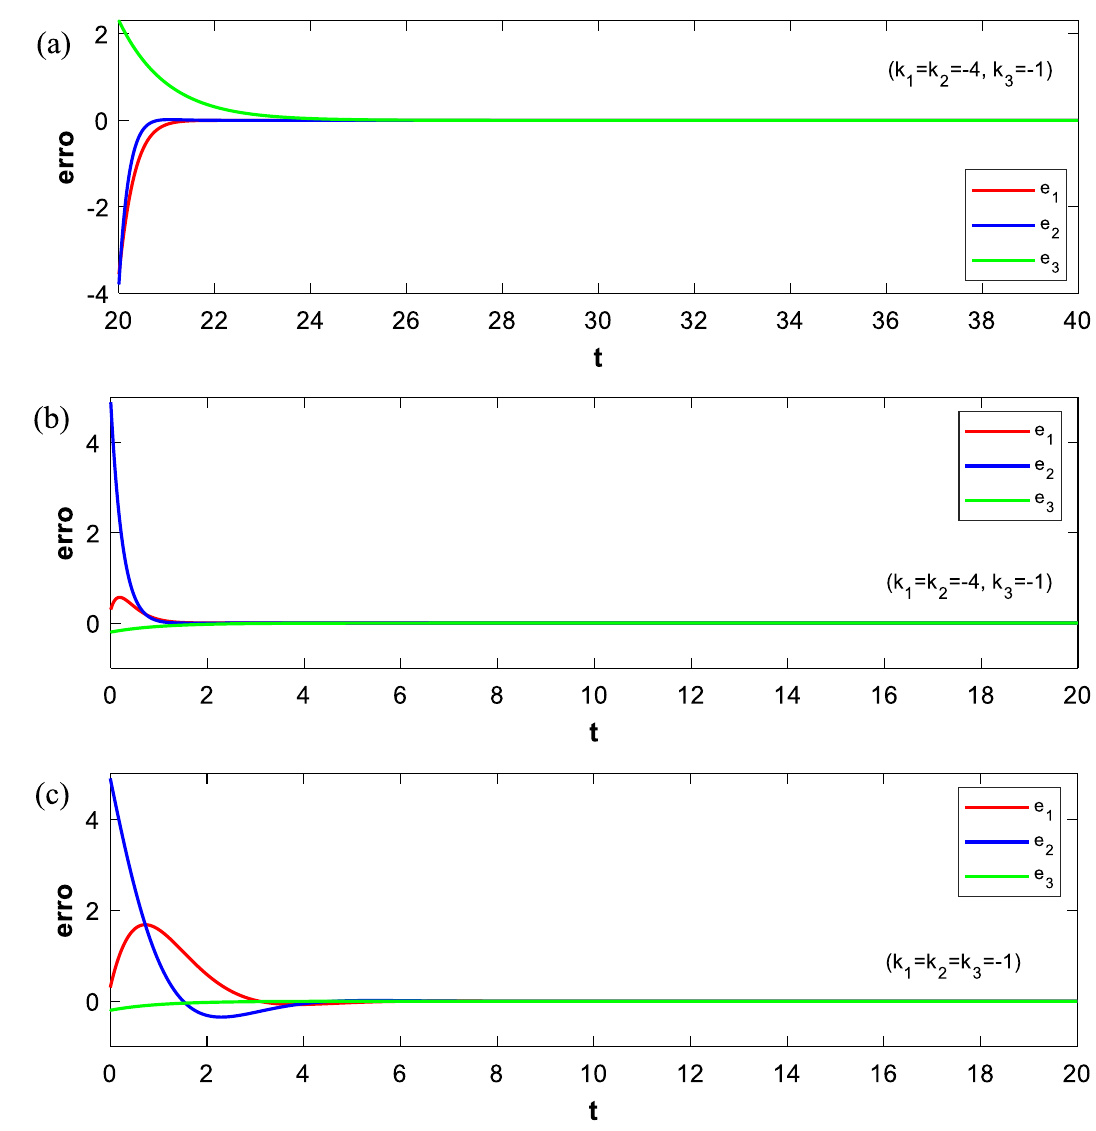
Figure 13. The trajectories of error functions with the controller activated at ( a ) t = 20 and 4, k 3 1 . ( b ) t = 0 and k 1 k 1 k 2 = = − = −